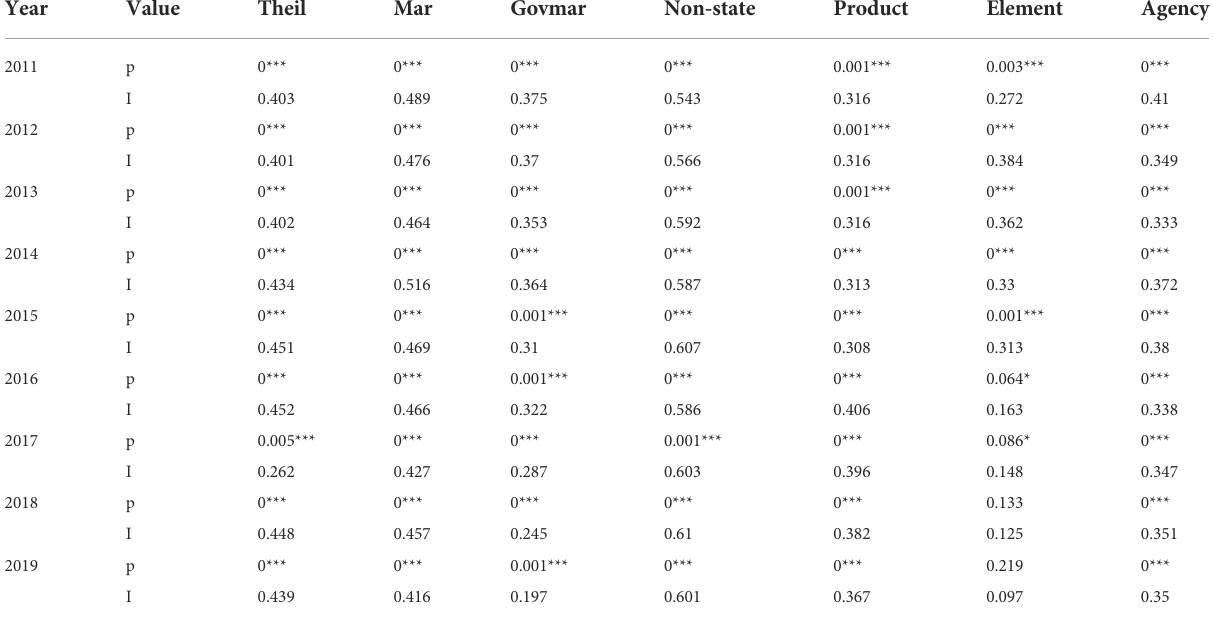
TABLE 4 Business environment and the urban – rural income gap Moran ’ s I value.